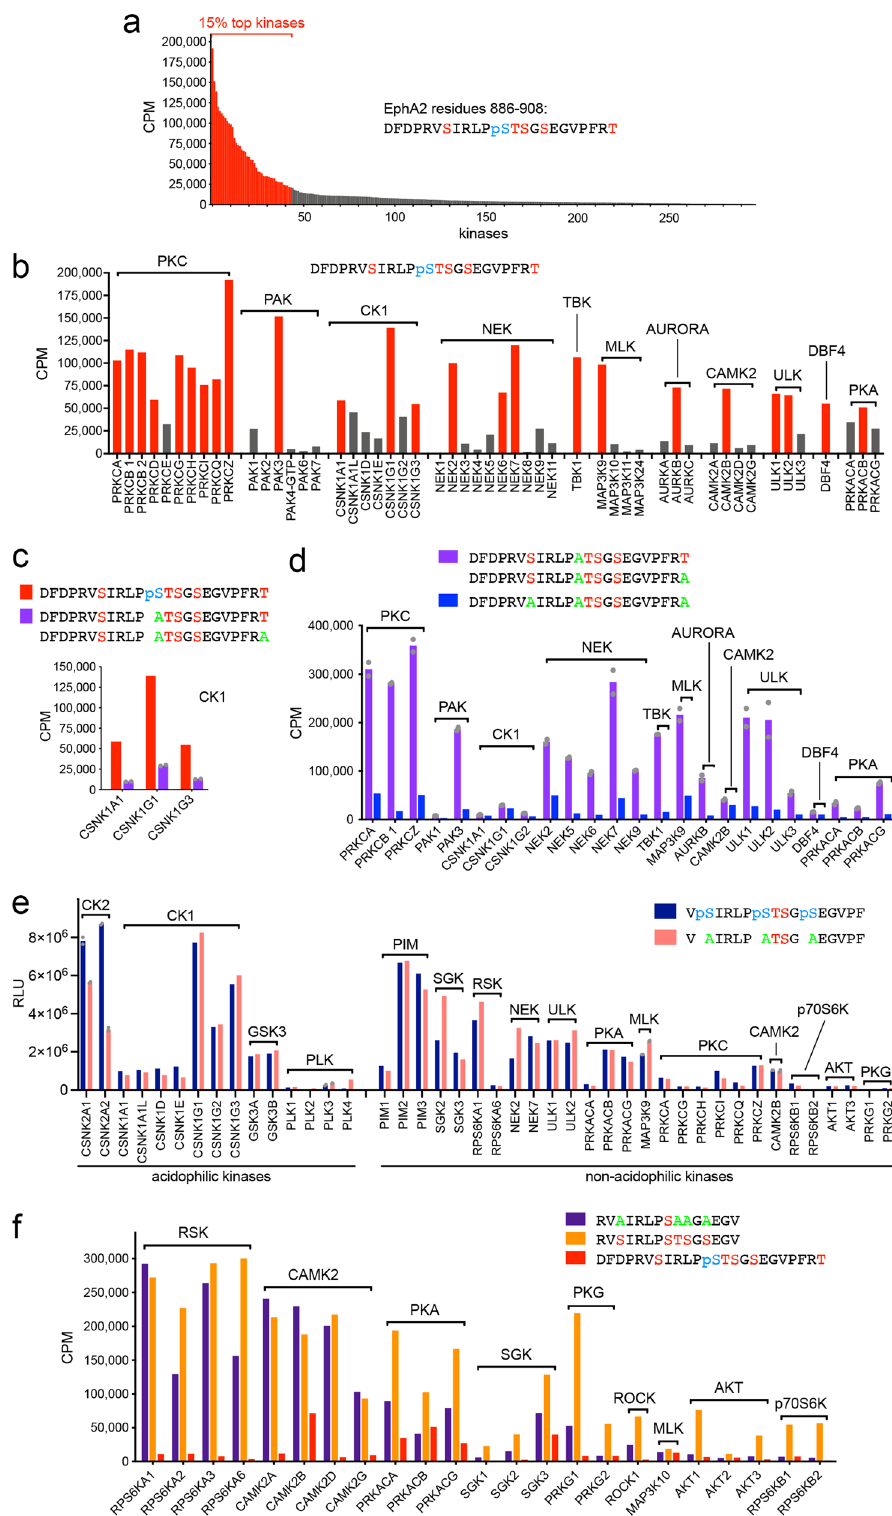
Discussion How the different parts of the Eph receptor intracellular region — including the juxtamembrane segment, kinase domain, linker and SAM domain — are arranged and function together has remained an open question, in part due to lack of structural information that extends beyond single domains and adjacent regions 14,37,53